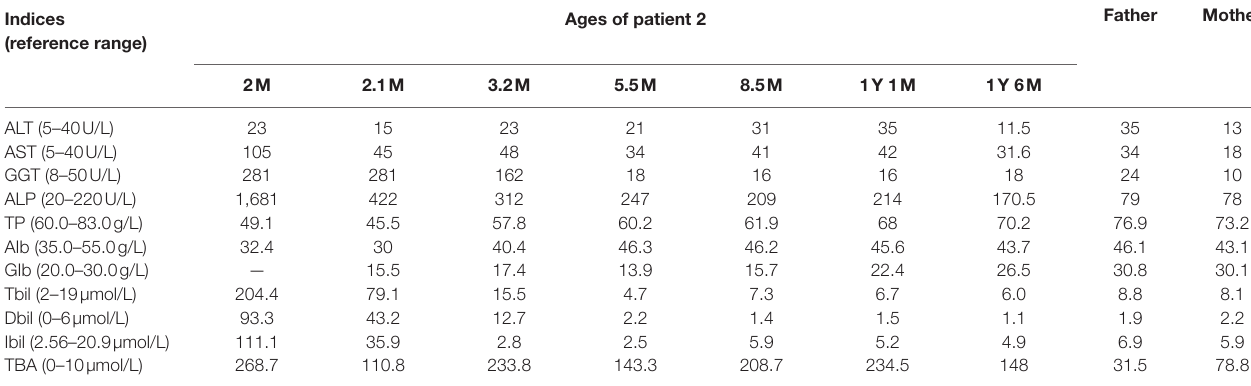
TABLE 2 | Biochemical changes over time in patient 2 and the parents. Indices (reference